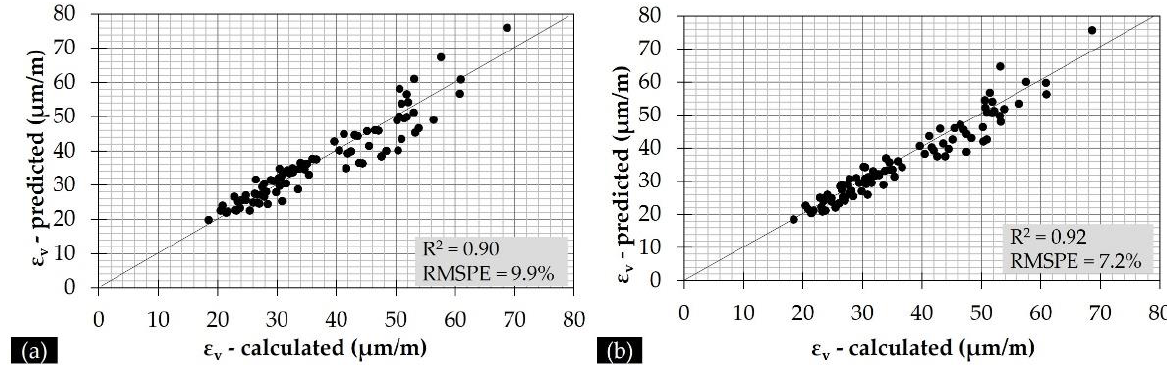
Figure 13. Calculated versus predicted subgrade strains considering as input: ( a ) DBPs (Case I), and ( b ) DBPs and IRI level (Case IV).